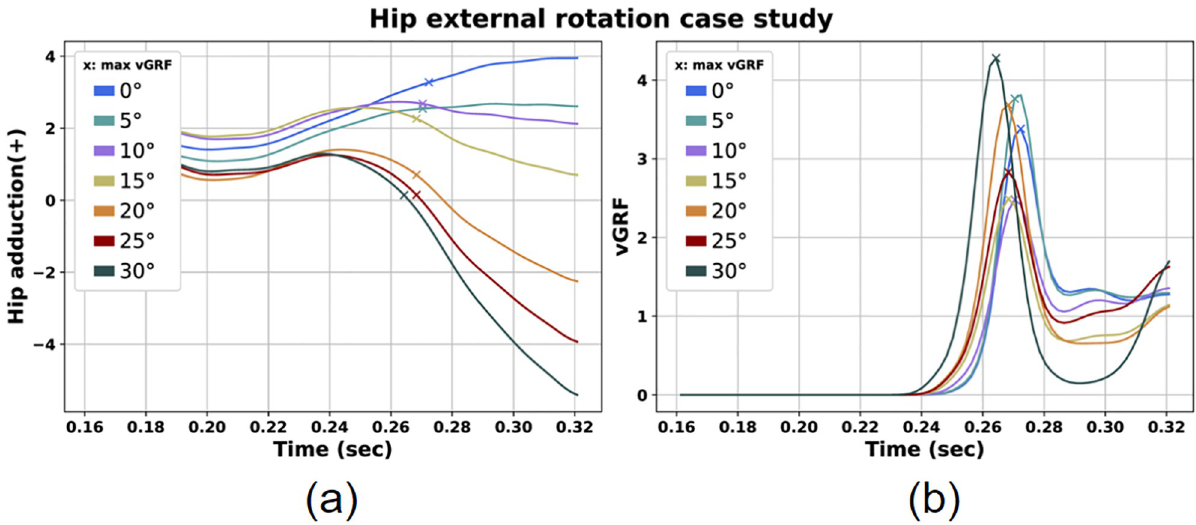
Fig 7. Hip adduction (a) and vGRF (b) for the hip external rotation case study.